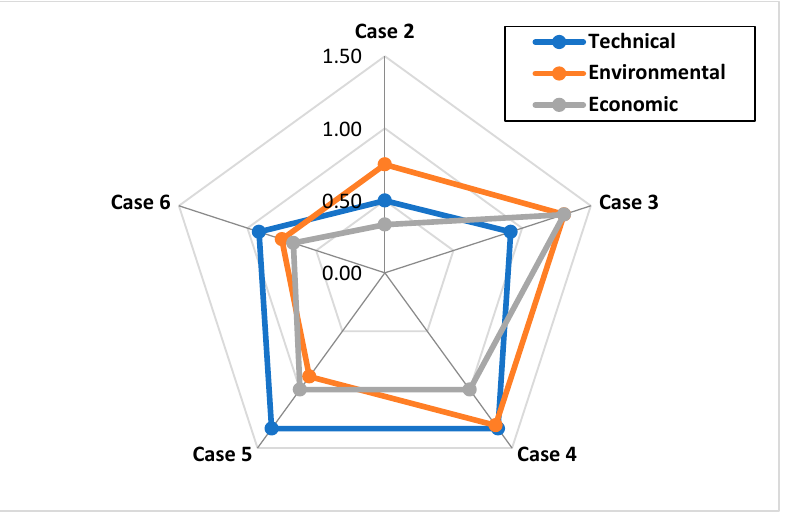
Figure 12. Global evaluation of solutions according to the three families of criteria.